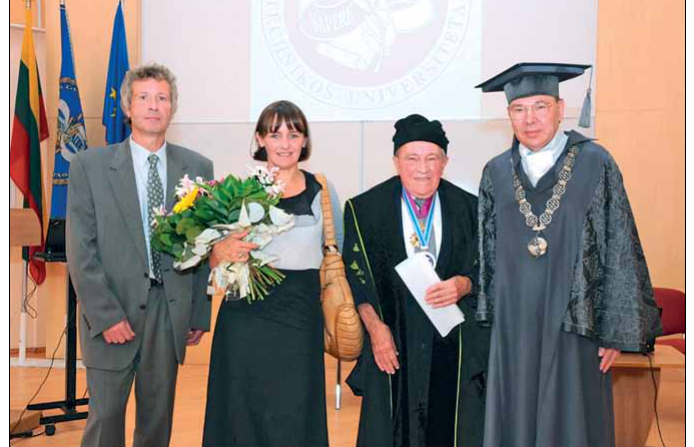
Fig. 2011: nomination as Honorary Doctor at Vilnius Gediminas Technical University of Prof. Brauers in presence of his daughter and son-in-law and with Prof.